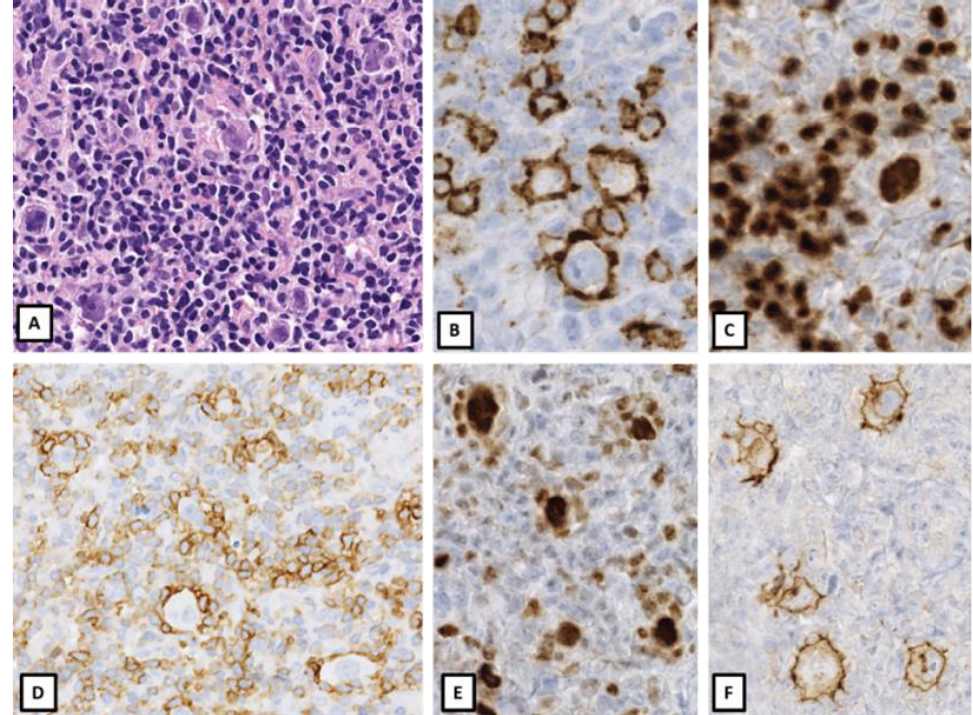
Figure 3. CD30+ Nodular lymphocyte predominant Hodgkin lymphoma. Enlarged axillary lymph node of a 63-year-old male patient. Nodal infiltrate of prominent LP cells in a background of small lymphocytes ( A ) strongly positive for CD20 ( B ) and PAX5 ( C ). PD1 positive T helper lymphocytes ( D ) rosetting around BCL6 positive LP cells ( E ). LP cells exhibit CD30 positivity ( F ). The prominent expression of B cell markers and the PD1+ rosettes exclude a diagnosis of CHL despite CD30 expression. (Original magnification: ( A ): × 400; ( B – F ): × 600).